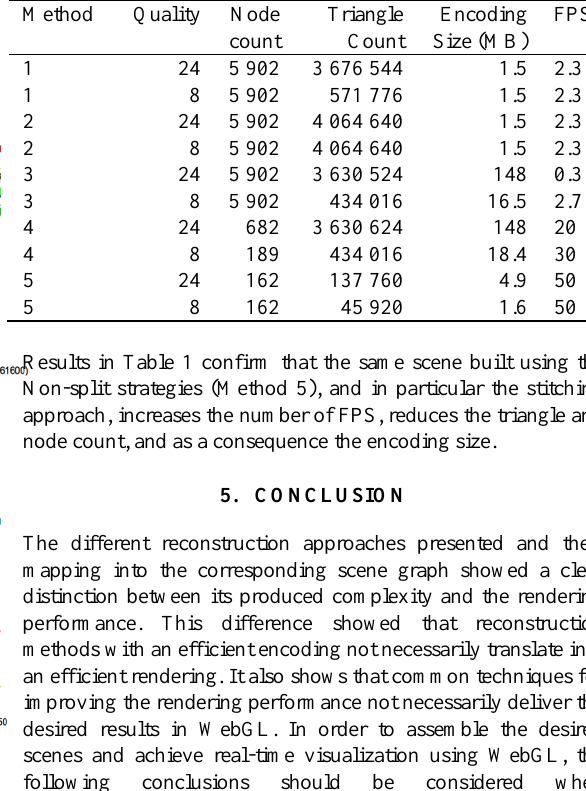
Figure 5: Results of the tests